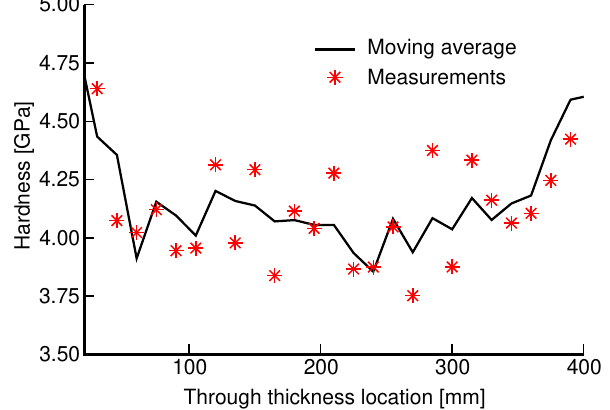
Figure 1. Variation in microhardness throughout the wall